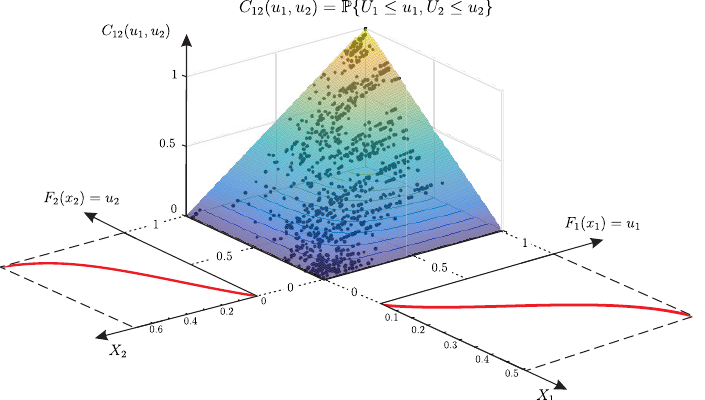
Figure 2. Schematic representation of a copula C ( u 1 , u 2 ) fitted to the marginals F 1 ( x 1 ) and F 2 ( x 2 )